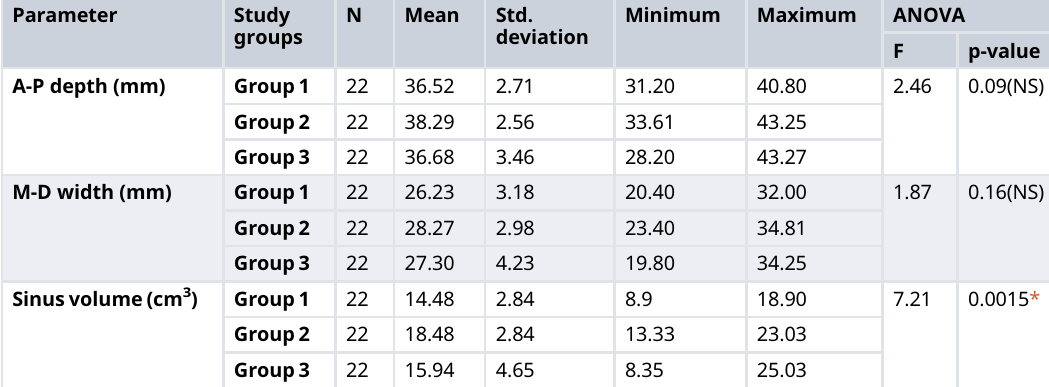
Table 3a. Comparison of Maxillary sinus depth, width and volume between the study groups. Parameter